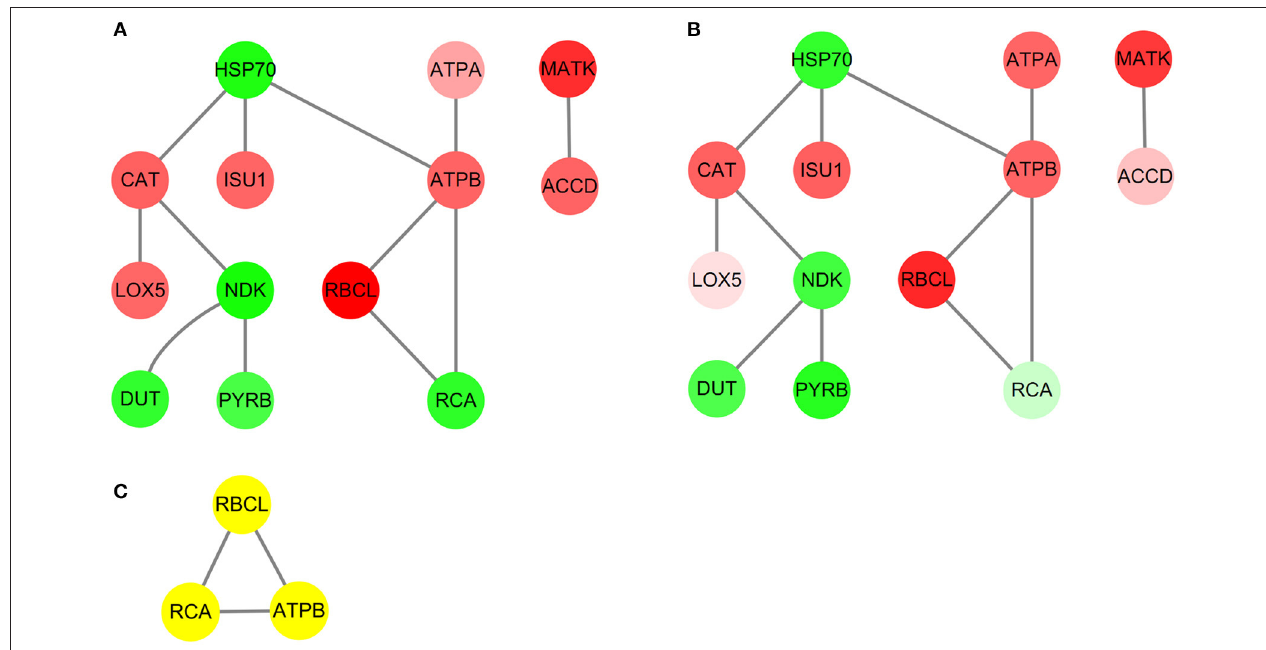
FIGURE 7 | The protein-protein interaction (PPI) network analysis in the leaves of three different ecotypes reed. The upregulated or downregulated proteins are presented in red or green. (A) HSMR vs. SR; (B) DR vs. SR; and (C) result of clustering analysis in PPI network.